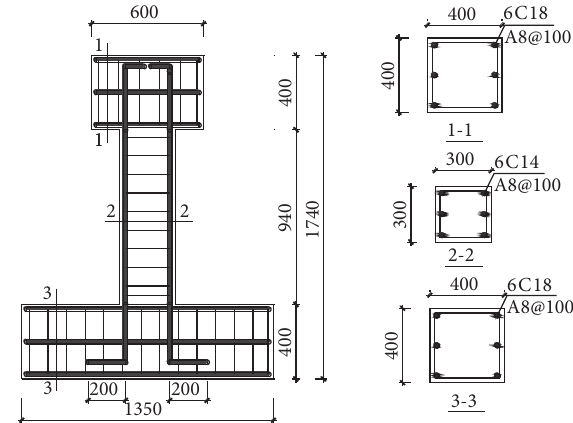
Figure 1: Specimen size and reinforcement details.